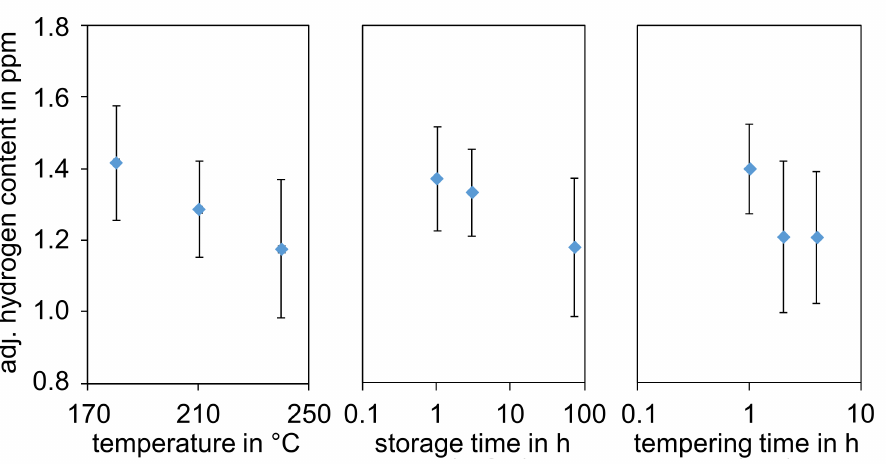
Figure 4. Effect of the factors tempering temperature, storage time and tempering time on the hydrogen content after tempering.